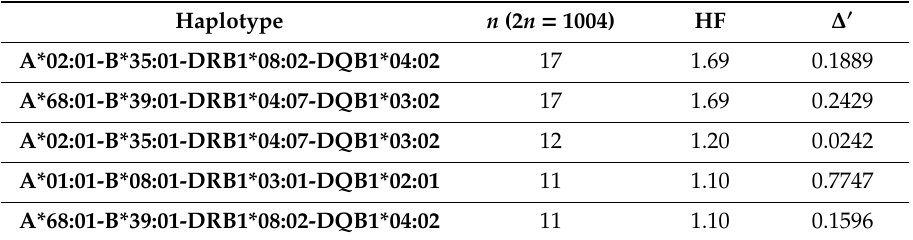
Table 6. HLA-A-B-DRB1-DQB1 haplotypes from